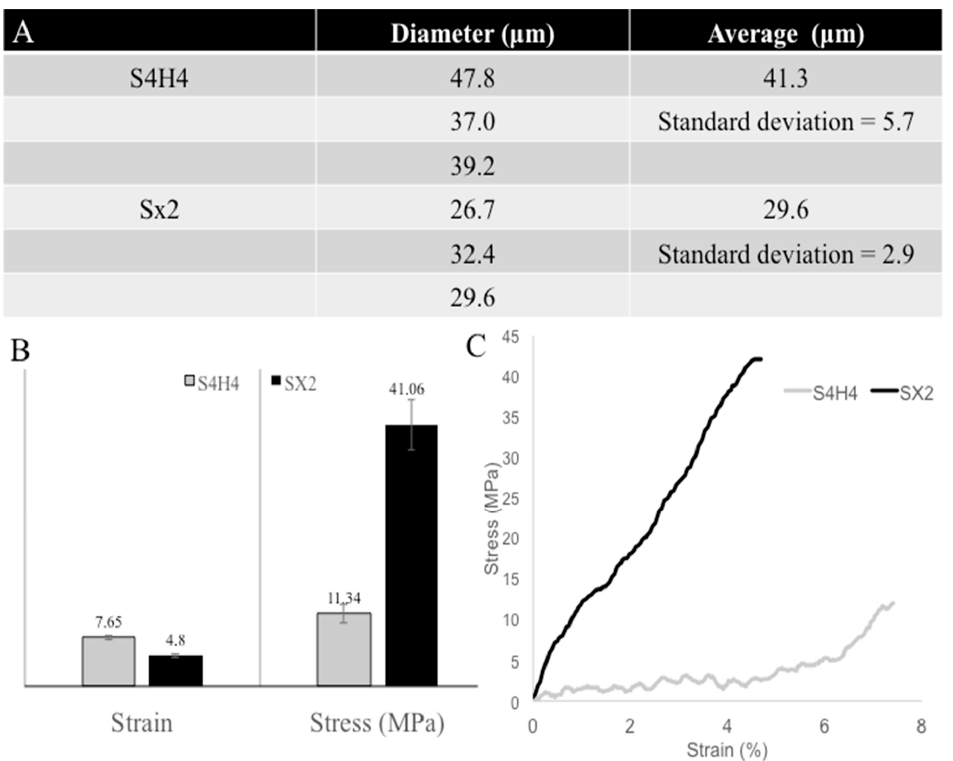
Figure 8. Comparison of the ( A ) wet spun fiber diameters, ( B ) average stresses and strains at breakage produced by SX2 and S4H4 fibers, and ( C ) an average stress/strain curve. S4H4 fibers were thick with decreased stress and increased strain compared to